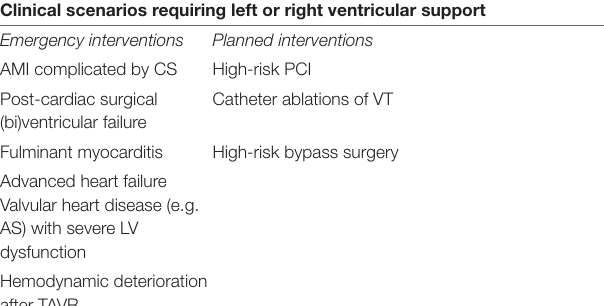
TABLE 5 | Indication for ventricular unloading. Clinical scenarios requiring left or right ventricular support Emergency